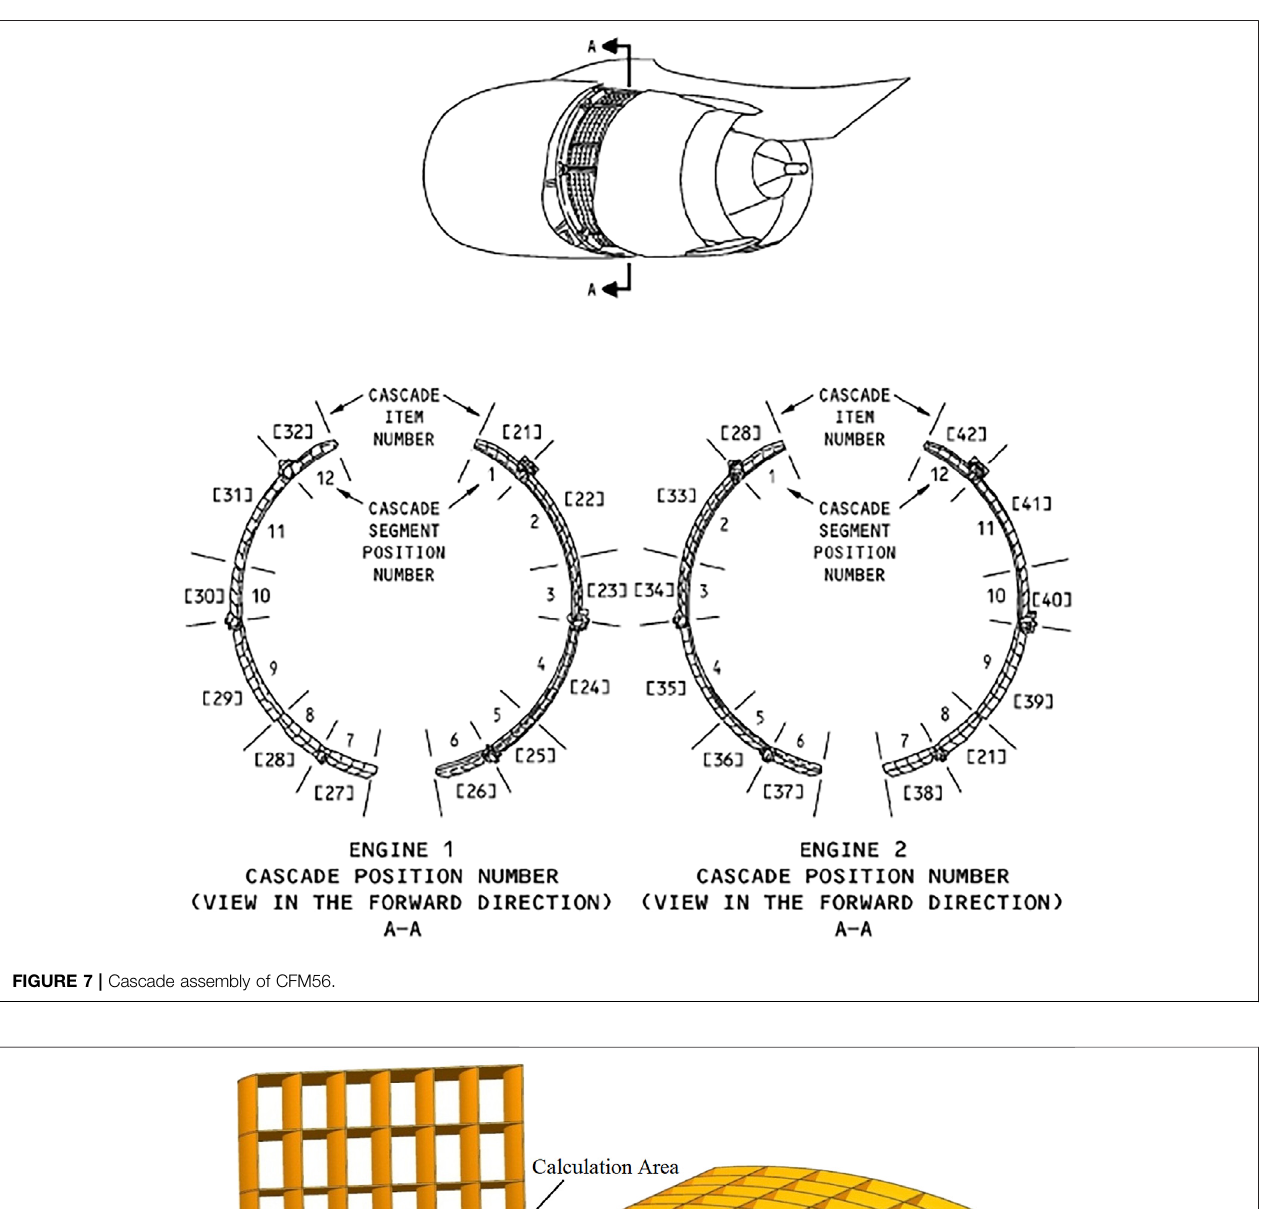
FIGURE 7 | Cascade assembly of CFM56.